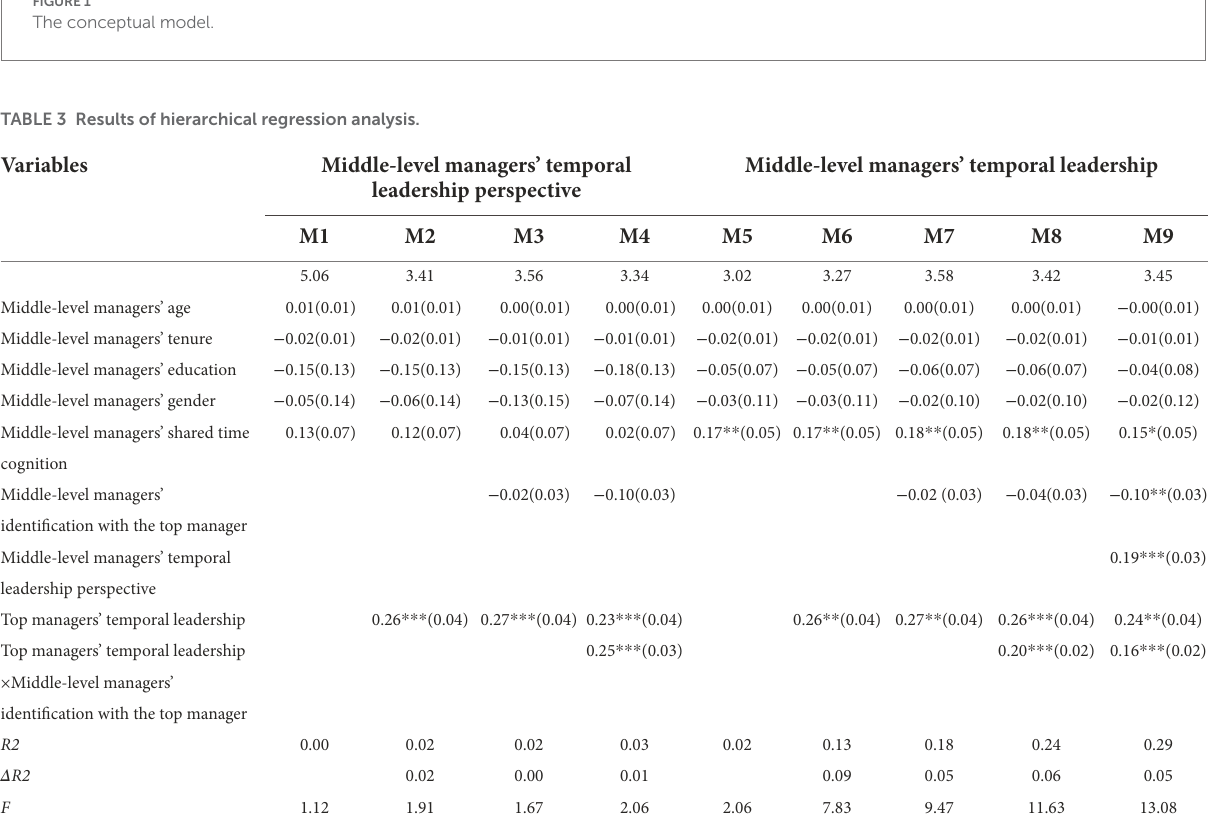
FIGURE 1 The conceptual